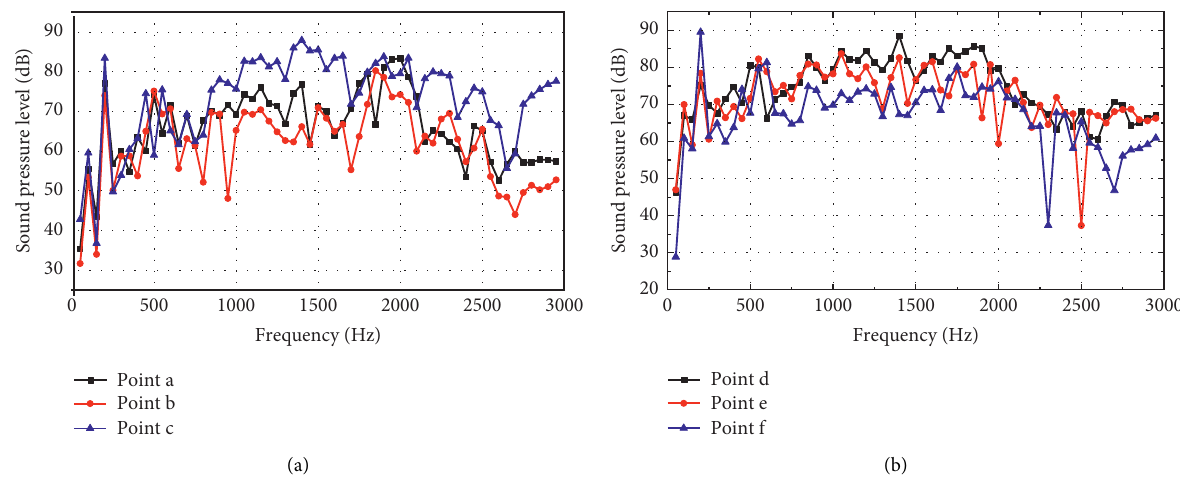
Figure 9: Sound pressure level of the six monitoring points with frequency. (a) In the xoy plane. (b) In the yoz